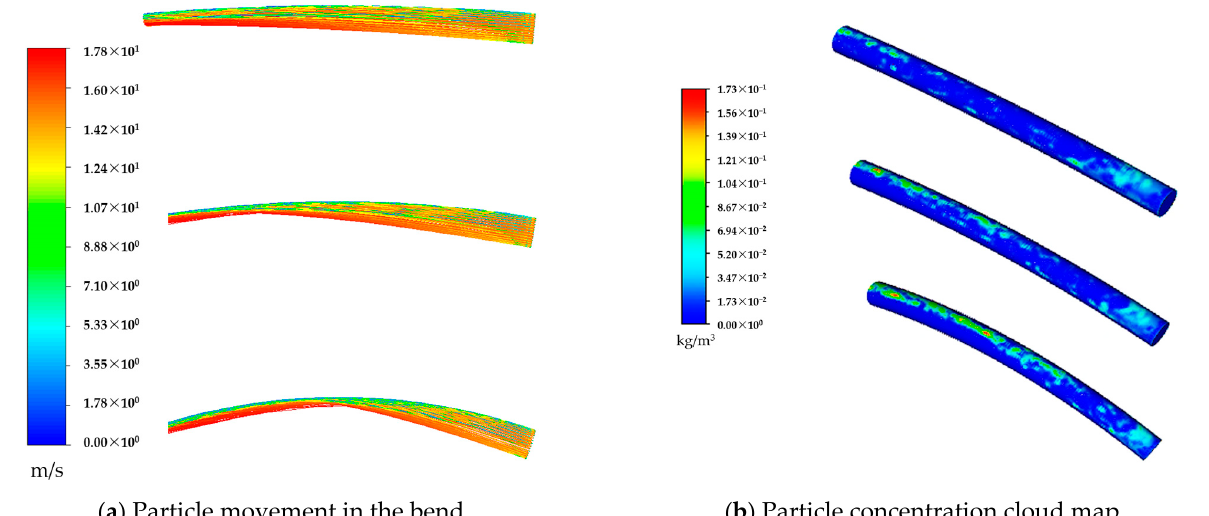
Figure 9. Particle movement and concentration distribution in the bend at different curvature radii. The maximum erosion rate of each erosion model is different. The maximum erosion depth was calculated based on the maximum erosion rate of the four models and compared with the maximum erosion depth tested by the experiment, and the best model was selected. When the radius of curvature is 1.5 m, the maximum erosion rate of the Generic model is 1.96 × 10 − 10 kg/(m 2 s). The maximum erosion wear rate of the DNV model is 1.28 × 10 − 7 kg/(m 2 s), and that of the Mclaury model is 1.47 × 10 − 6 kg/(m 2 s). The maximum erosion depth calculated by Generic, DNV and Mclaury models is quite different from the maximum erosion depth tested by the experiment, and the reliability is not good. The maximum depth of erosion of the pipe for the Finnie model calculated according to formula (17) with different radii of curvature is shown in Table 4. The variation rule of the erosion depth calculated by the model is basically consistent with the experimental results, and the average error of the erosion rate is 8.3%. Considering the system error and random error involved in the experimental measurement, the Finnie model has high accuracy in the simulation calculation of the erosion rate of gas–solid two-phase flow.